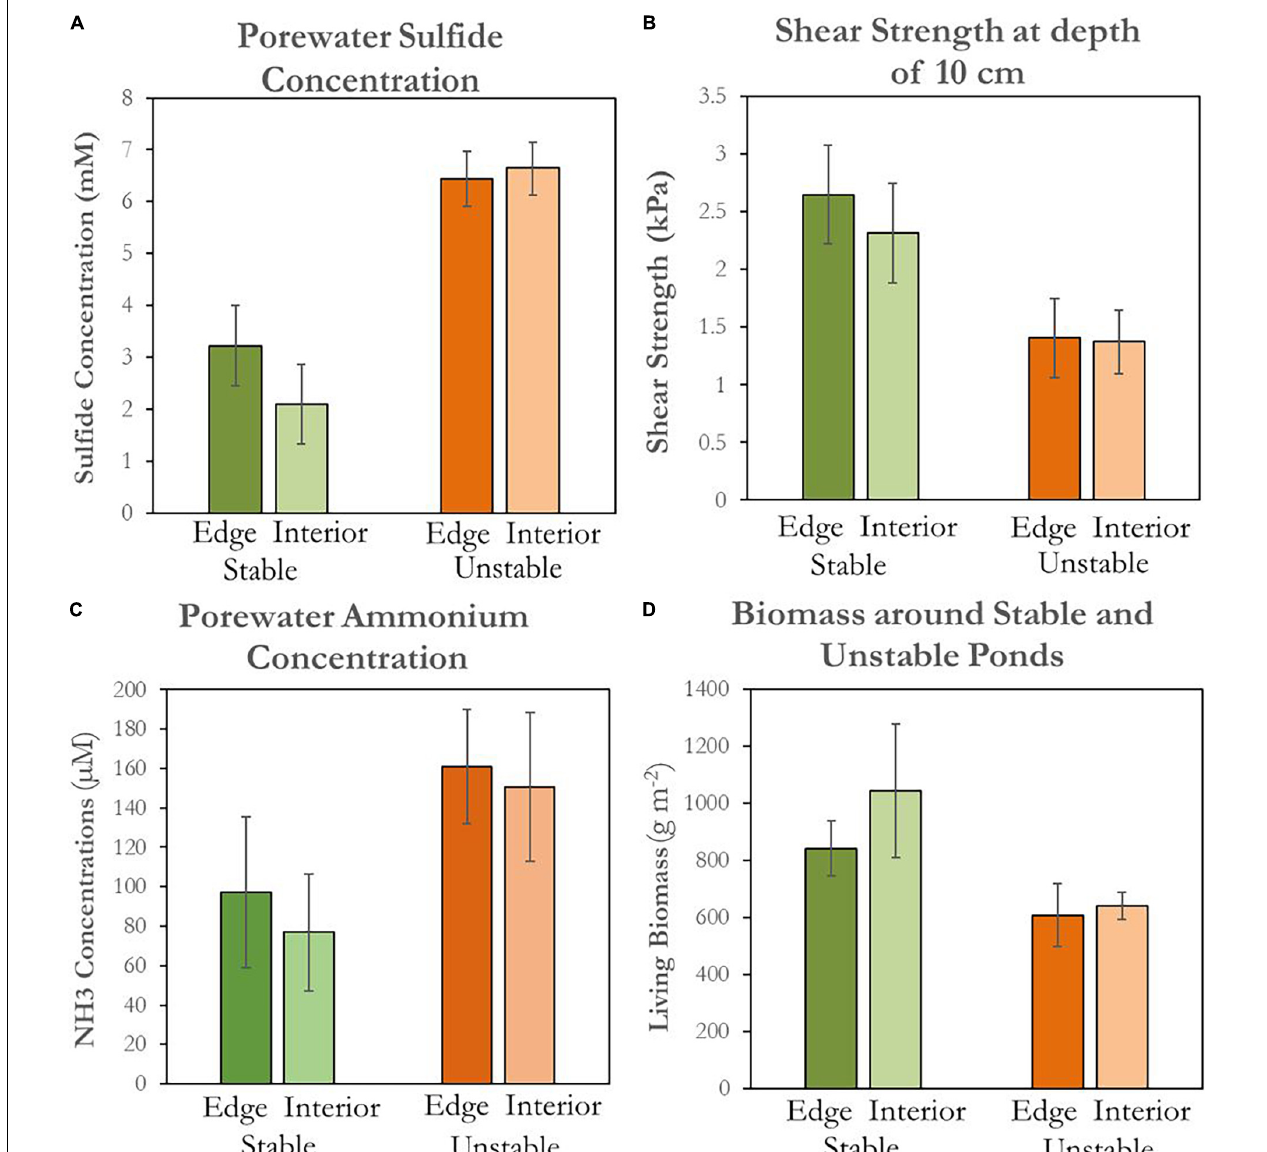
FIGURE 10 | Soil porewater chemistry surrounding stable and unstable ponds. Each bar represents the average of all measurements ( n = 9) collected at a certain pond type and location. Error bars represent ± standard error. Green bars represent conditions around stable ponds and orange bars represents conditions around unstable ponds. Darker shades represent conditions at 1m from the pond edge and lighter shades represent conditions 10 m away in the marsh. (A) Concentrations for sulfide in millimolar. (B) Shear vane soil shear strength in rooting zone (10 cm soil depth) measured in kPa. (C) Concentrations for ammonium in micromolar. (D) Living biomass in g m − 2